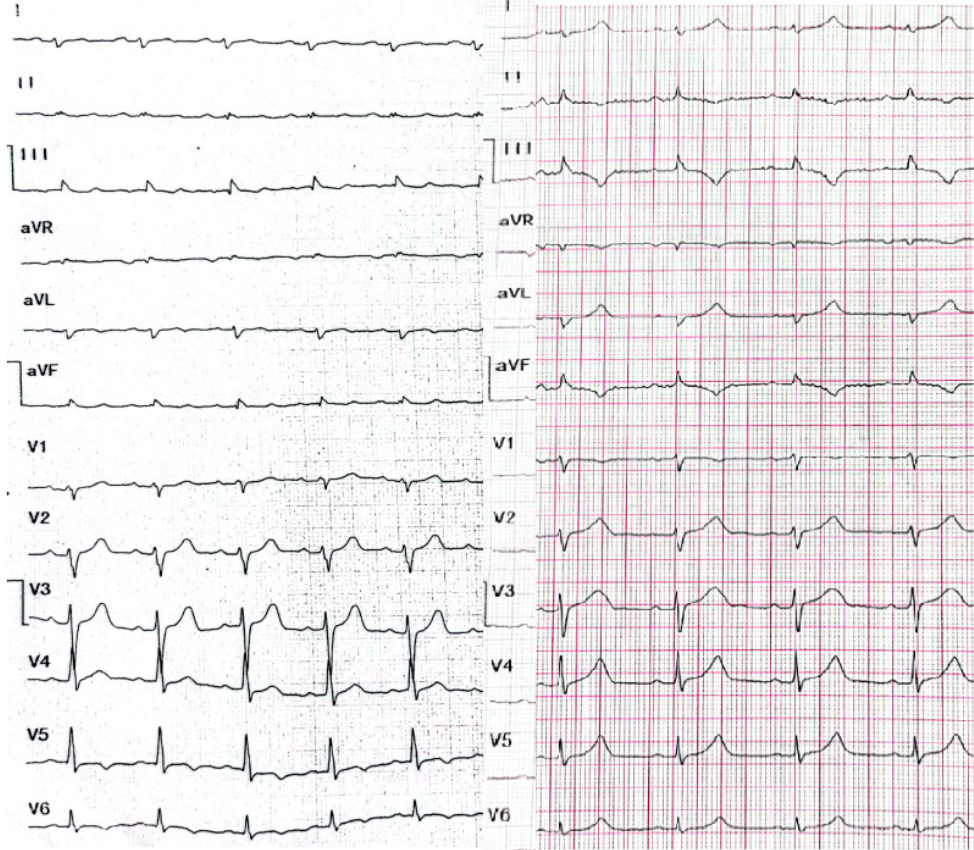
Figure 1. Resting electrocardiograms at standard paper speed of 25 mm/s and normal calibration of 1 mV = 10 mm (description in the text).